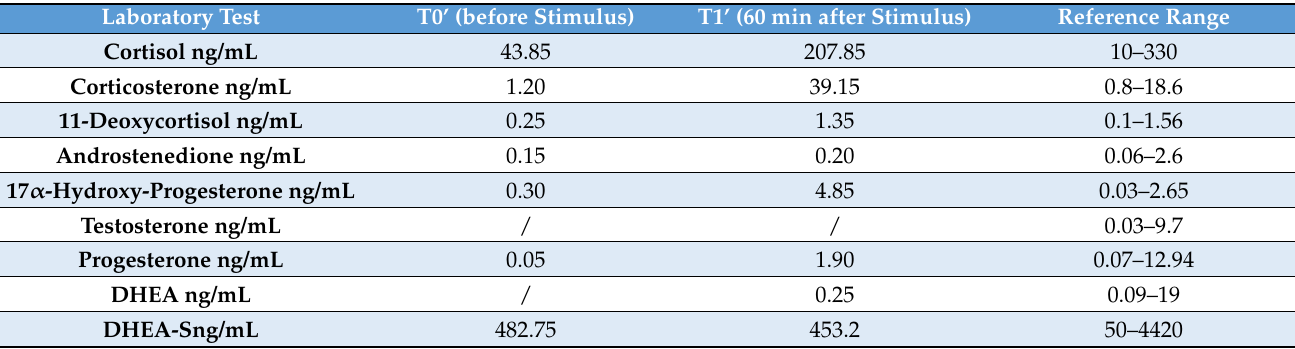
Table 4. Serum steroid levels measured before and after stimulation with